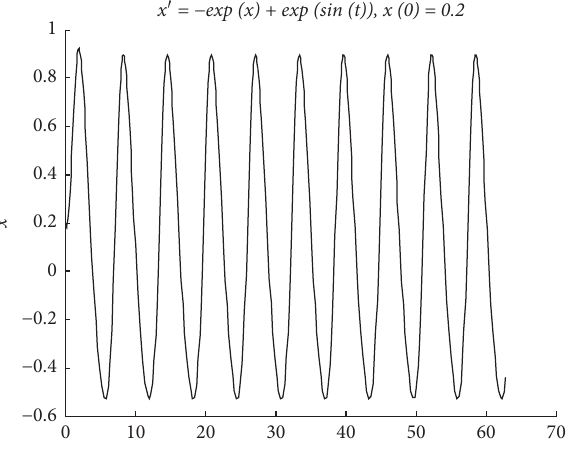
Figure 1: The curve of the solution of equation (79) with initial value x ( 0 ) � 0 . 2.